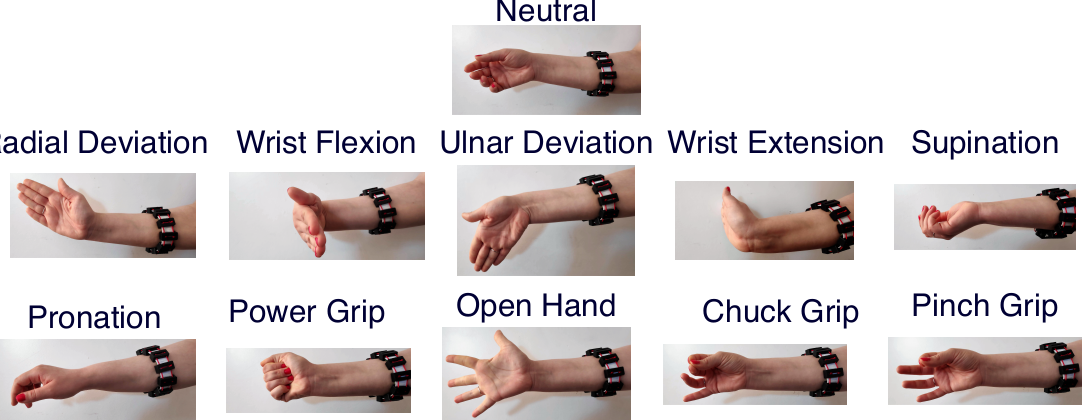
Figure 7. The eleven hand/wrist gestures employed in the proposed